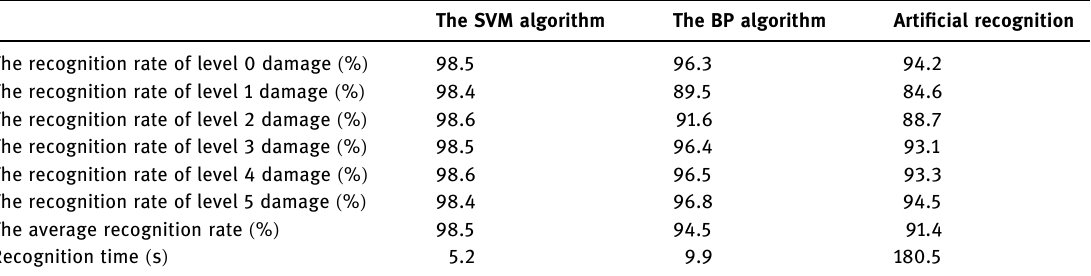
Table 2: Detection results of package surface damages by the arti fi cial recognition method, the BP algorithm, and the SVM